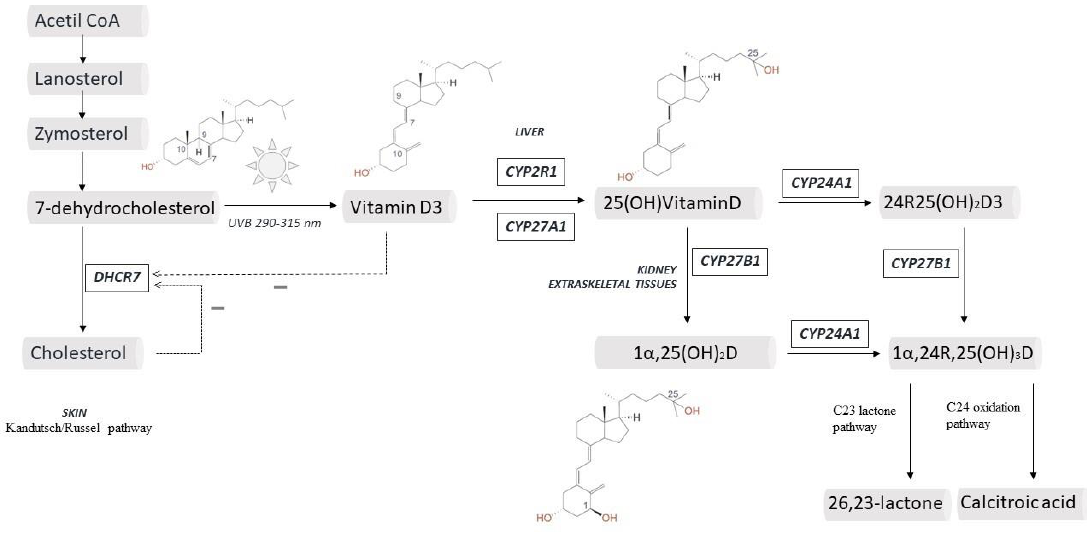
Figure 1. Crucial steps in vitamin D metabolism.